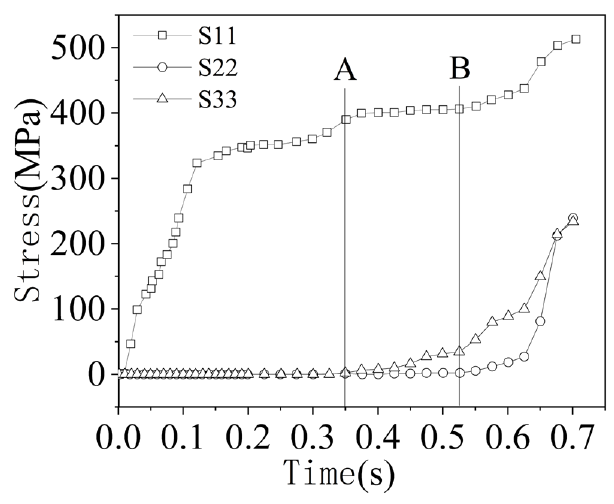
Figure 3. Schematic diagram of stress change at the necking point.